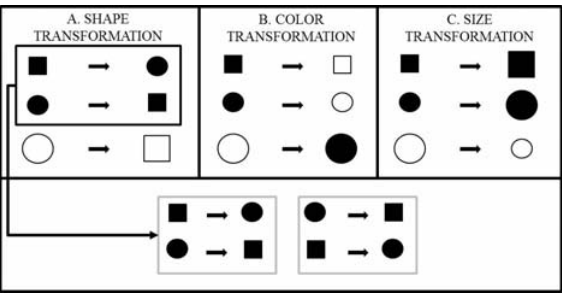
Figure 2. Logical manifold transformations along the dimensions of shape, color, and size for a set of objects defined over three dimensions. The fourth pane underneath the three top panes contains the pairwise symmetries revealed by the shape